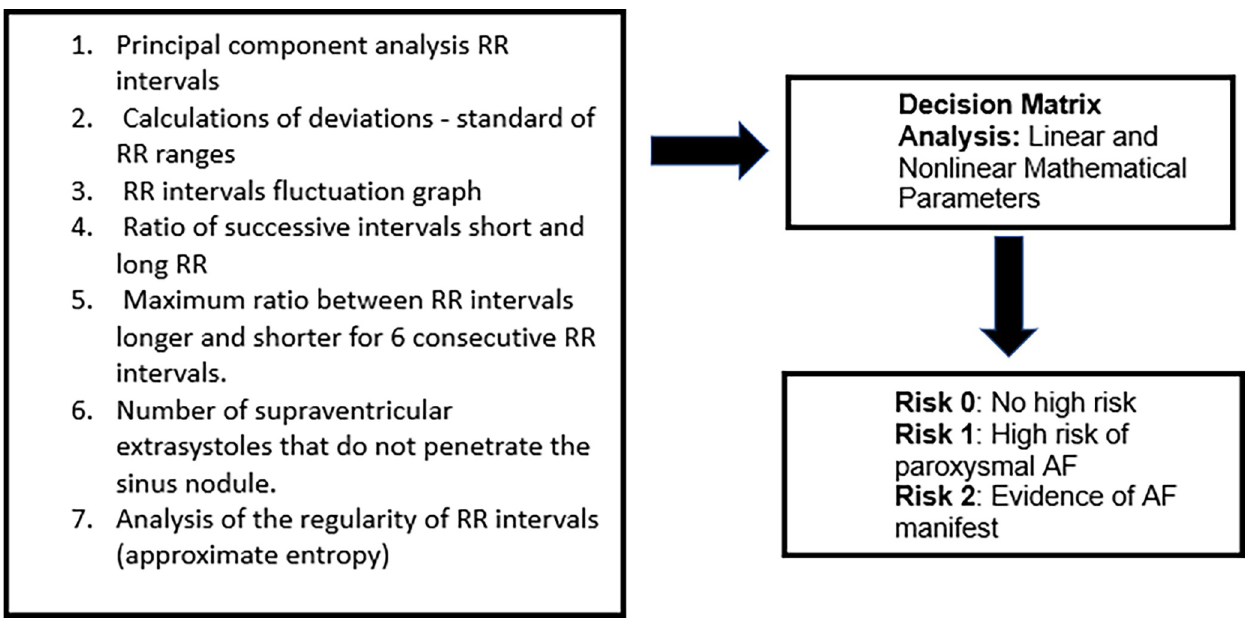
Fig 2. Components of the algorithm for electrocardiographic analysis used by the SRA.